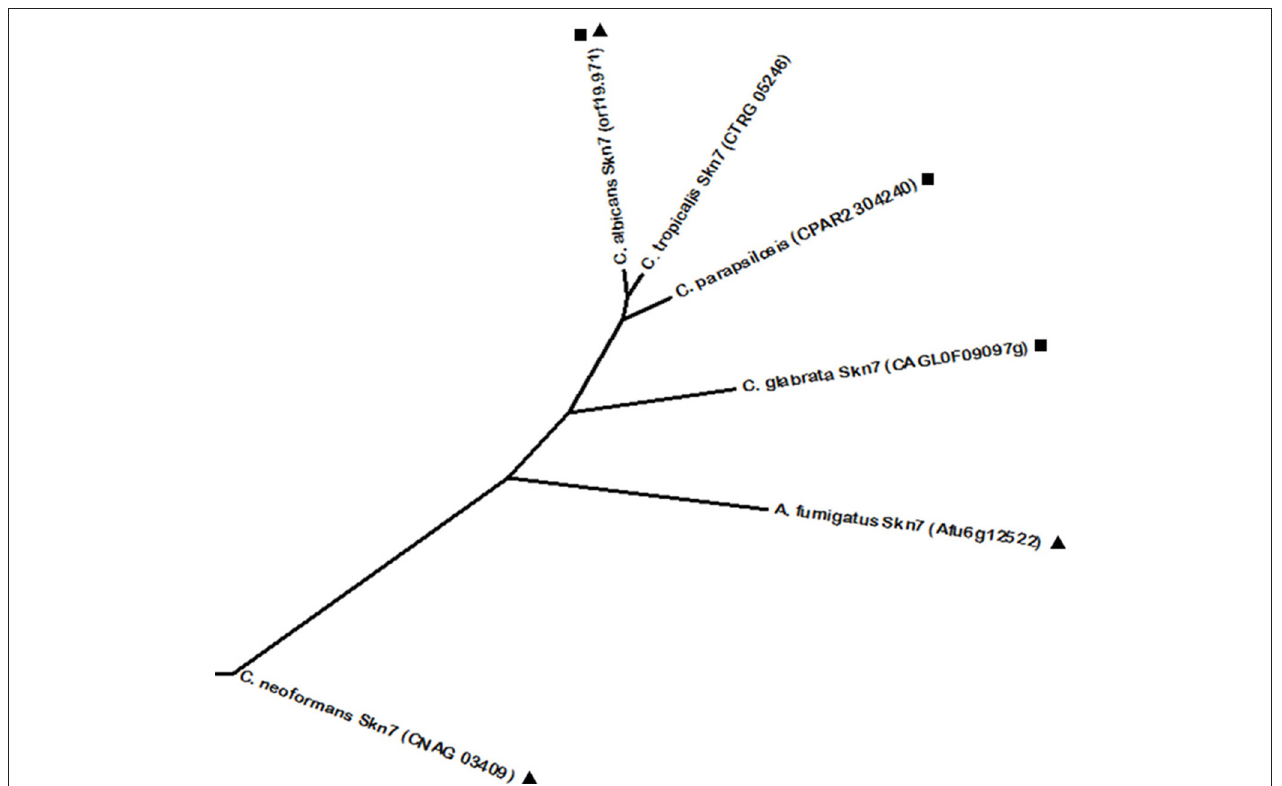
FIGURE 6 | Phylogenetic analysis of the C. albicans Skn7 and C. neoformans Skn7 homologs. Phylome predicted homologs of C. albicans Skn7 are marked with ( (cid:4) ). Phylome predicted homologs of C. neoformans Skn7 are marked with ( N ). Unmarked branches represent additional proteins showing some degree of similarity identified by BLASTp ( E < 10 − 50 ). The tree was constructed using the Molecular Evolutionary Genetics Analysis (MEGA 7) software (Kumar et al., 2016). Multiple alignments of the amino acid sequences were calculated by ClustalW algorithm (Sneath and Sokal, 1973). The tree is drawn to scale, with branch lengths in the same units as those of the evolutionary distances used to infer the phylogenetic tree. The evolutionary distances were computed using the JTT matrix-based method (Jones et al., 1992) and are in the units of the number of amino acid substitutions per site. The rate variation among sites was modeled with a gamma distribution (shape parameter =